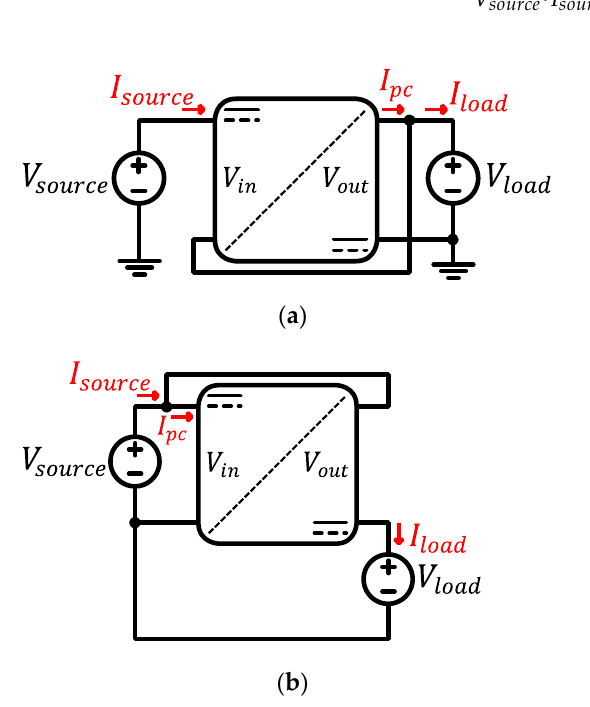
Figure 3. Step-down PPC architectures. ( a ) ISOP; ( b ) IPOS.